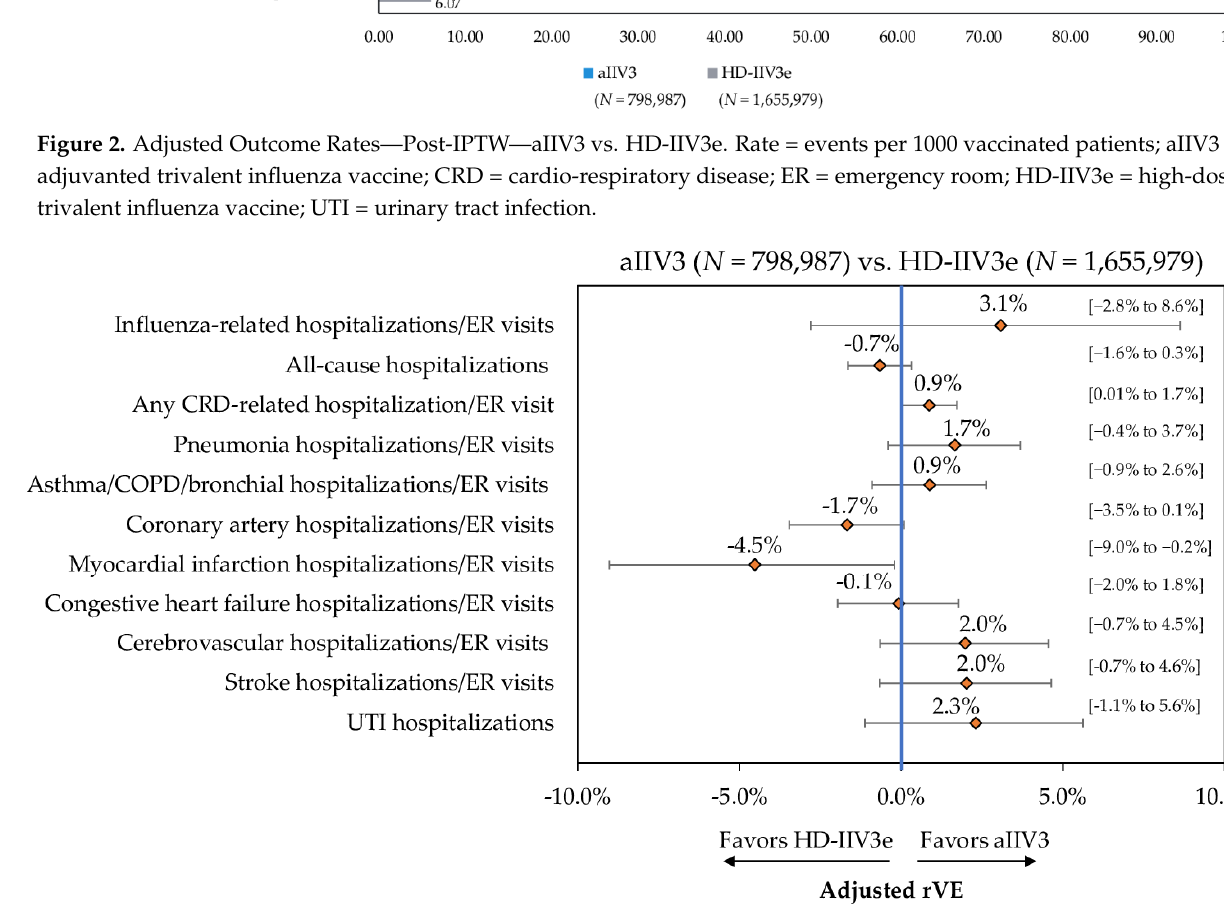
Figure 3. Adjusted rVE (95% CI)—Post-IPTW and Poisson Regression—aIIV3 vs. HD-IIV3e from Main Analysis. aIIV3 = adjuvanted trivalent influenza vaccine; CRD = cardio-respiratory disease; ER = emergency room; HD-IIV3e = high-dose trivalent influenza vaccine; rVE = relative vaccine effectiveness; UTI = urinary tract infection.